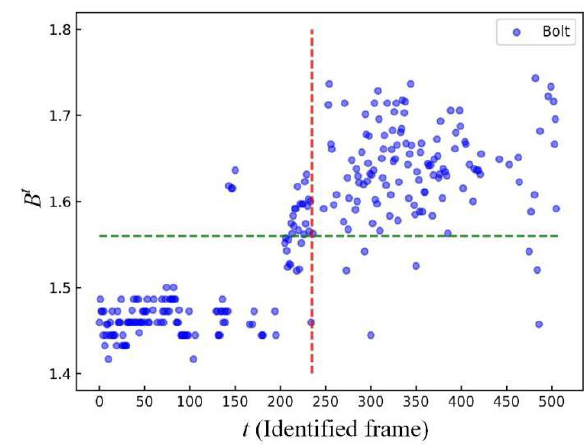
Figure 8. Scatter diagram of the average ratio B t of the bounding box height and width for each identified frame of Video Sequence I.